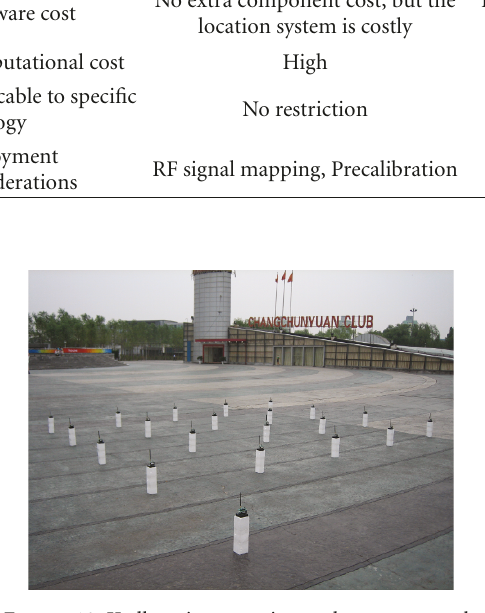
Figure 12: Kcdlocation experimental scene at a